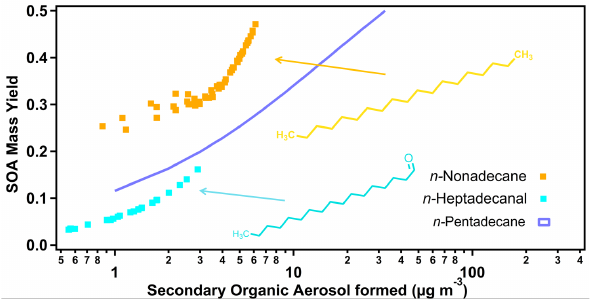
Figure 6. Pinonaldehyde + OH radical in the presence of NO x . Consumption of m/z 169 (molecular weight of pinonaldehyde + 1 in a PTR-MS), and the formation of m/z 155 (molecular weight of nor -pinonaldehyde +1). nor -Pinonaldehyde molar yield from the OH radical oxidation of pinonaldehyde in the presence of NO x is about ~ 50%.